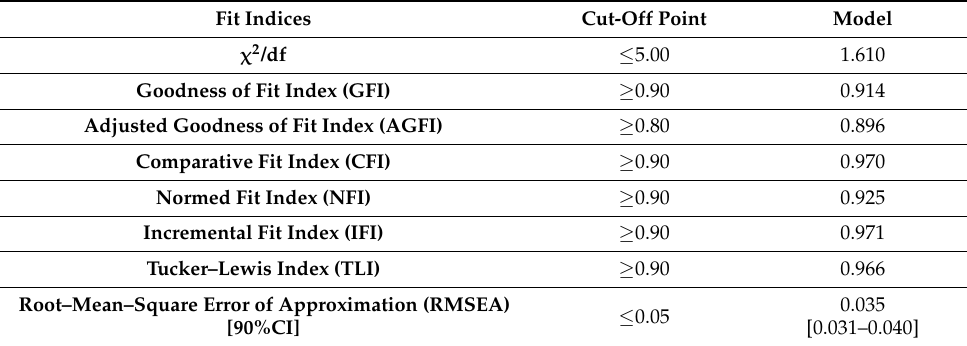
Table 3. Summary of model’s